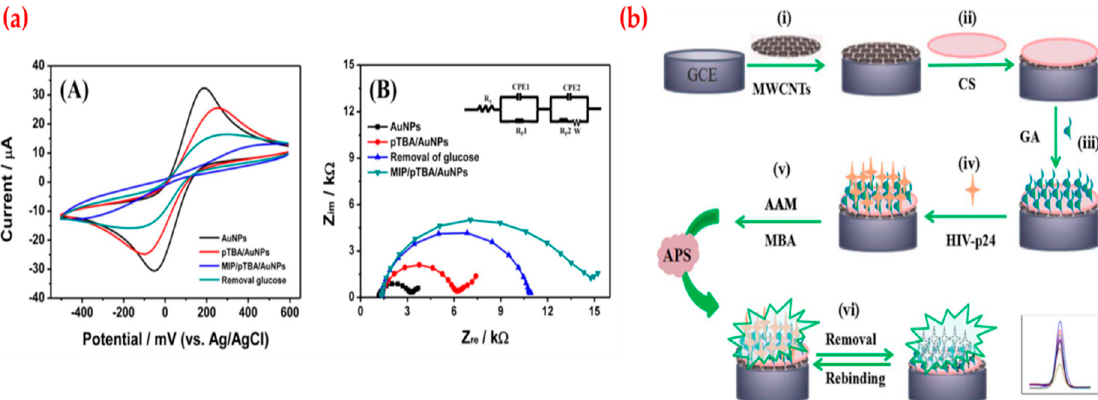
Figure 7. ( a ) Cyclic voltammetry curves (A) and Nyquist plots recorded for polymers (B) and ( b ) electron microscope image (A) and the size distribution (B), dark field electron image (C) and element mapping images of quantum dots (D-H). Republished with permission from [119,120]; permission conveyed through the Copyright Clearance Center, Inc.